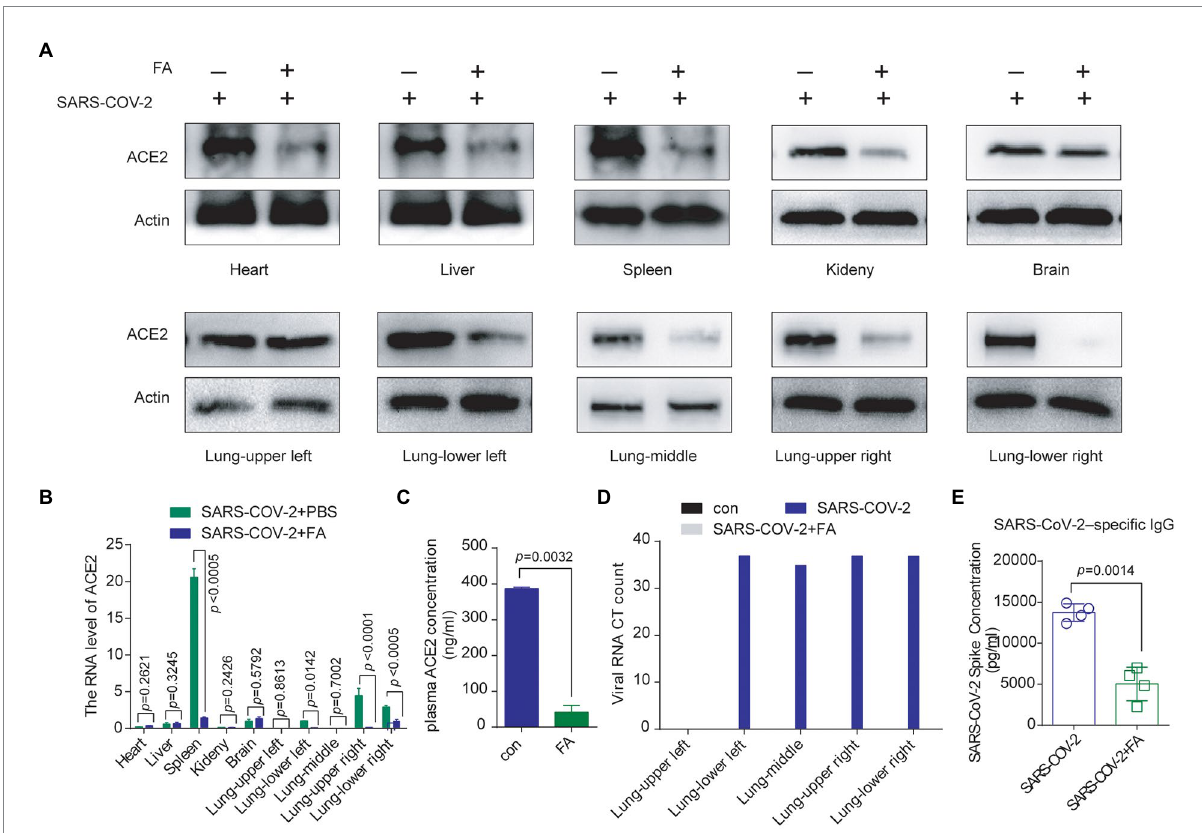
FIGURE 5 Folic acid treatment decreased ACE2 expression and inhibited SARS-CoV-2 invasion and SARS-CoV-2-neutralizing antibody production in vivo . (A) Folic acid treatment decreased ACE2 protein expression in the main organs of BALB/c mice. (B) The ACE2 mRNA level decreased in the main organs of folic acid-treated BALB/c mice, as examined by a qRT–PCR assay. (C) The plasma ACE2 protein concentration was decreased in folic acid-treated BALB/c mice, as detected by ELISA. (D) Folic acid treatment decreased SARS-CoV-2 invasion, and SARS-CoV-2 RNA levels were decreased in each part of the BALB/c mouse lung. (E) SARS-CoV-2–specific neutralizing antibody levels were decreased in folic acid-treated BALB/c mice, as detected by